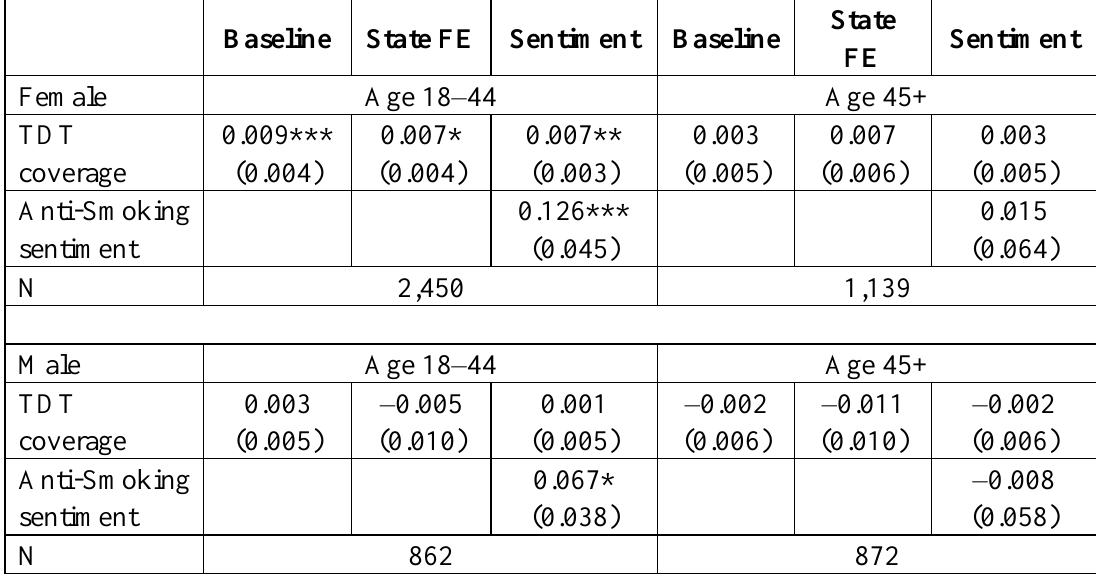
Table 3. Probit model of smoking